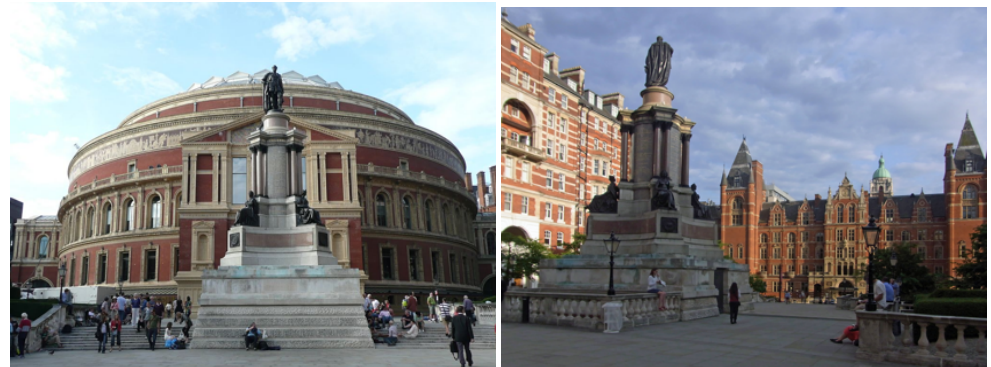
Figure 1. Left image : view of the site with the Prince Albert sculpture and Albert Hall in the background. Right image : view of the site with the Royal College of Music Building and the Albert Court in the